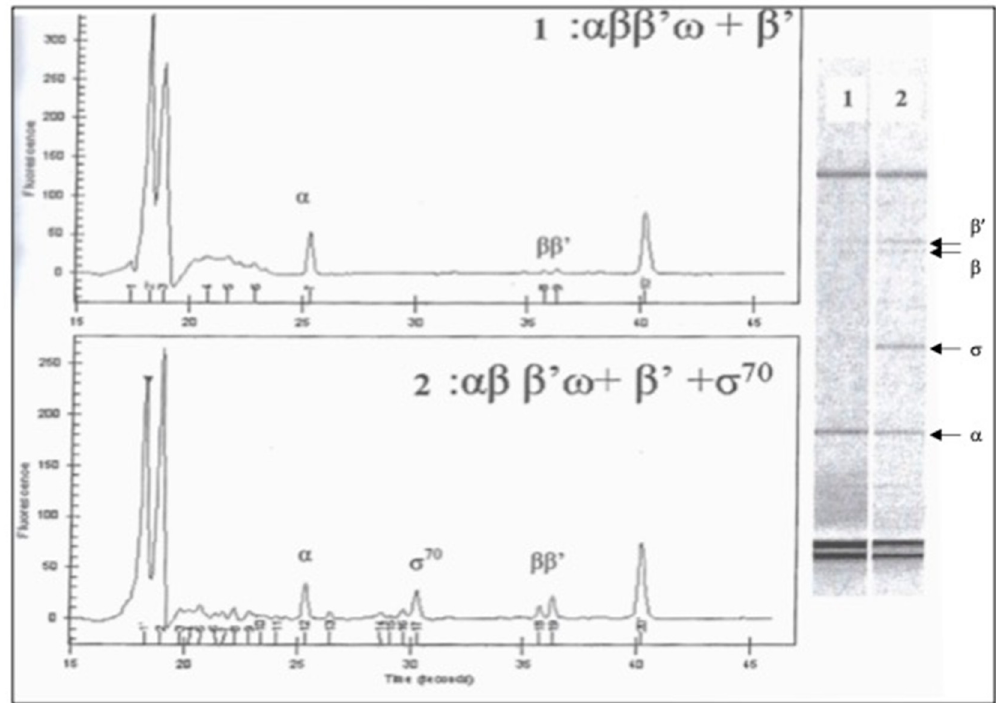
Figure 3. Analysis of E. coli RNA polymerase overexpressed in living cells. Detection of RNA polymerase subunits by capillary microelectrophoresis without σ factor (1) and with added σ 70 factor (2). Factor σ 70 was purified separately and added to the purified proteins obtained in the soluble fraction.